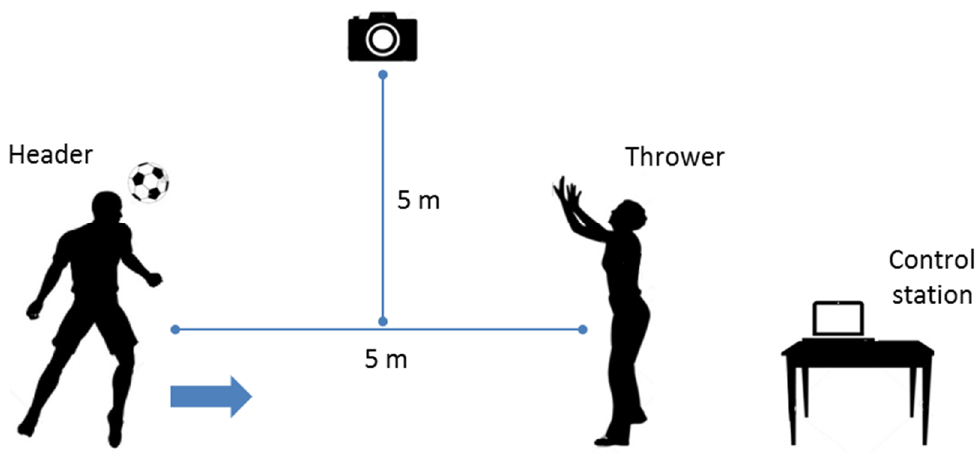
Figure 2. Diagram showing the experimental set-up for the forward heading measurements. The distance between the ball thrower and the participant is 5 m. The arrow indicates the direction of heading. The control station contains a computer and the electromyography (EMG) device.